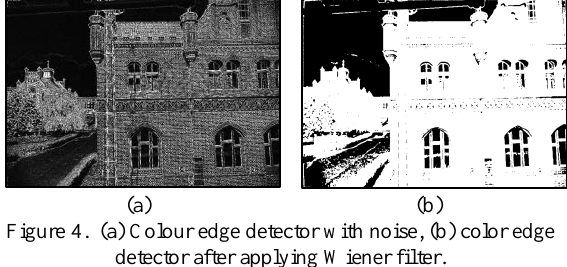
Figure 4. (a) Colour edge detector with noise, (b) color edge detector after applying Wiener filter.